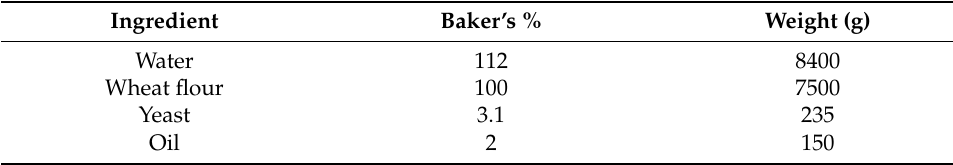
Table 2. Formulation used to prepare ferment.